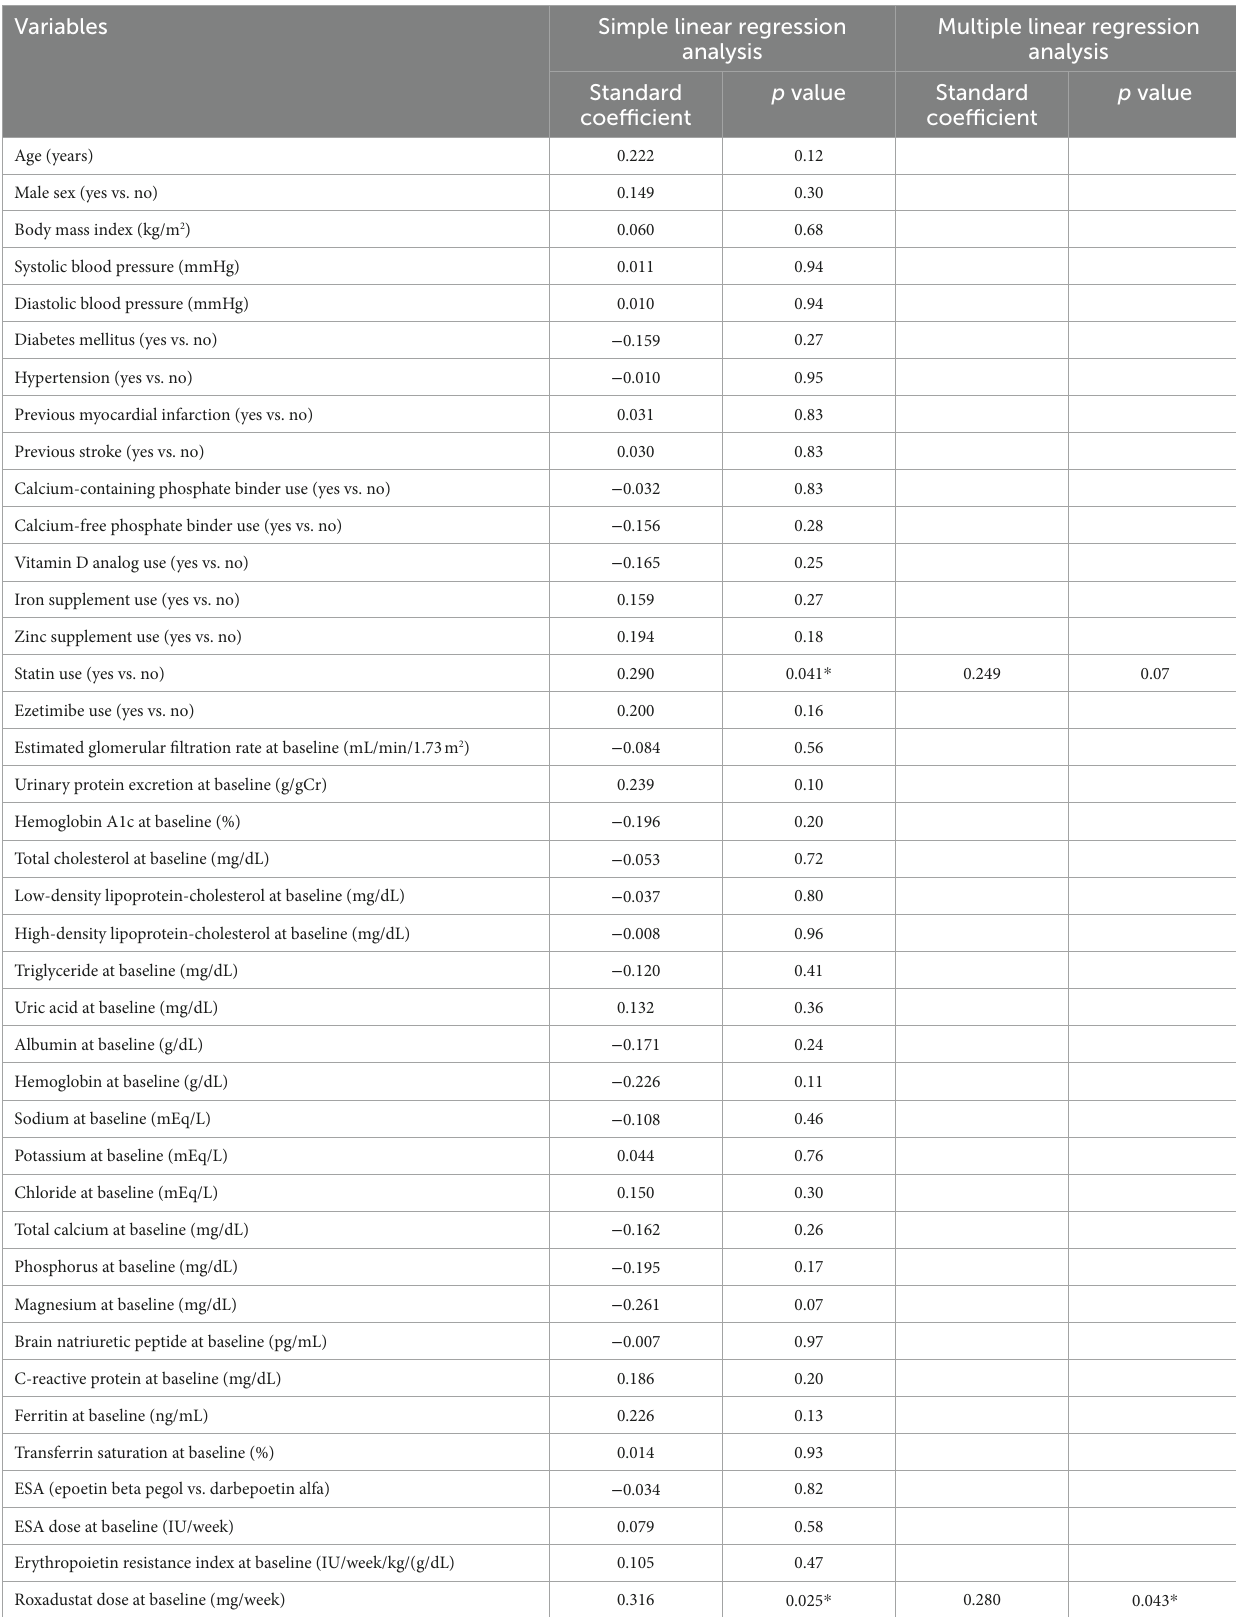
TABLE 2 Simple and multiple linear regression analyses of the variables correlated with the change in hemoglobin levels during the first 4 weeks of roxadustat administration.